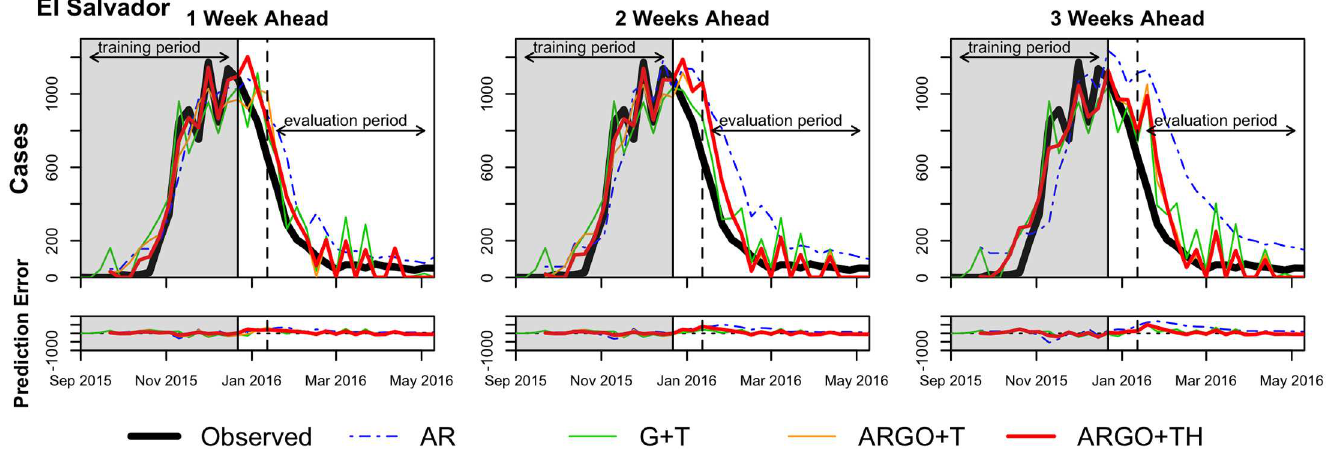
Fig 3. Prediction results for El Salvador. The weekly estimationsof AR (dotted blue), G+T (green), ARGO+T (orange), and ARGO+TH (red) models are comparedto the official case counts (black). The best model performance (lowest relativeRMSE) in each time series is shown as a boldedline.